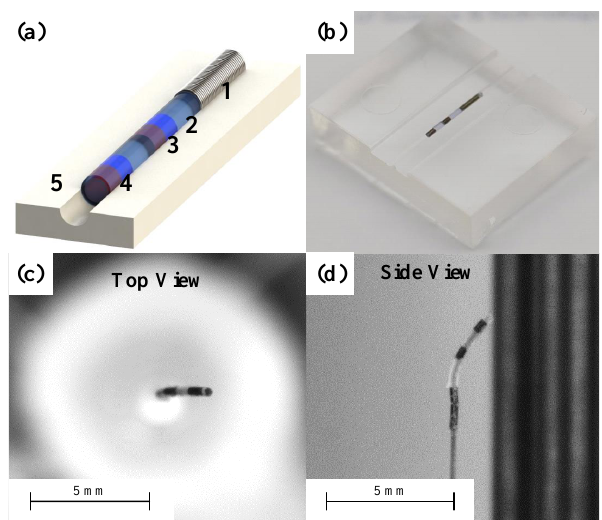
Figure 3. Fabrication of the flexible microrobot. ( a ) The polydimethylsiloxane (PDMS) mold and the microrobot, (1) the micro-spring; (2) PDMS block (3) first magnet (4) second magnet (5) PDMS mold; ( b ) fabricated microrobot on the PDMS mold; ( c ) top, and ( d ) side views of the microrobot during the steering